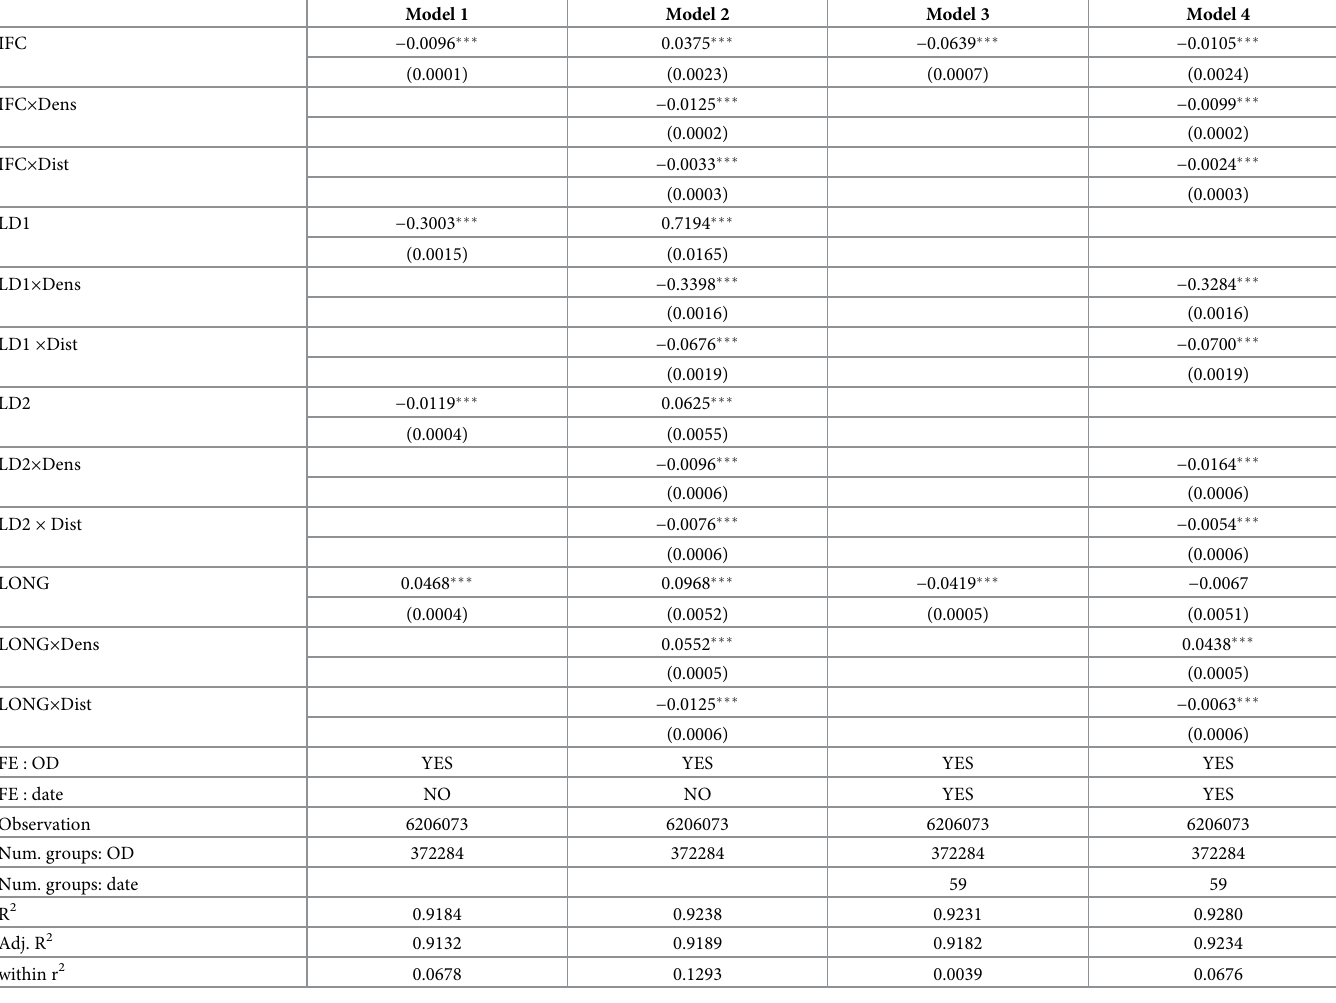
Table 3. Estimation results for the weekend